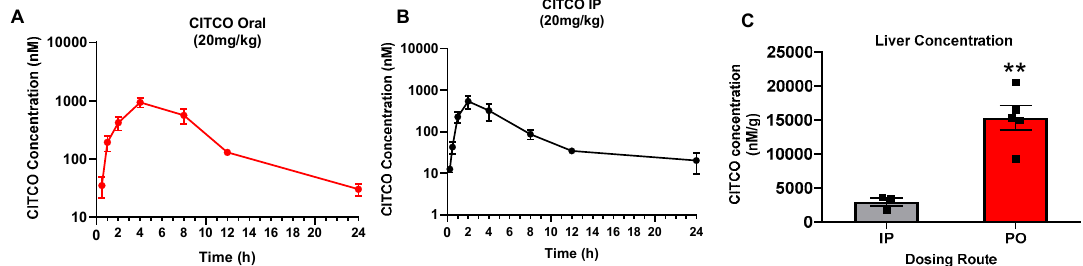
Figure 5. Oral administration of CITCO results in preferential hepatic disposition. hCAR-TG-mice were treated with CITCO at 20 mg / kg via IP or PO as detailed in Section 2. Plasma concentrations of CITCO after PO ( A ) and IP ( B ) were measured using LC-MS / MS analysis at the indicated time points. CITCO concentrations in the liver tissues ( C ) were detected 4 h post-IP or PO administration. Data represent the mean ± SEM, n = 3 / group. **, p < 0.01. Table 2. CITCO Pharmacokinetic parameters from hCAR-TG-mice dosed 20mg/kg via PO and IP route.